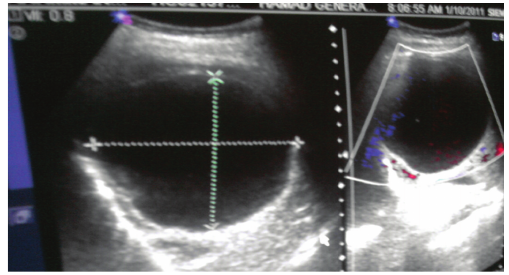
Figure 2: Abdominal ultrasound revealed a well-defined cystic lesion in the right liver lobe, likely hydatid